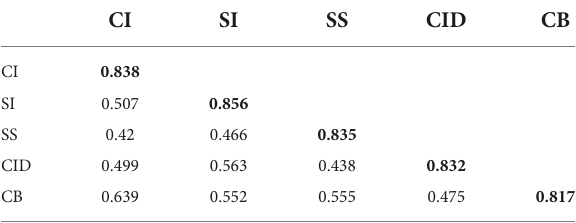
TABLE 3 Construct correlation and square roots of AVE values.